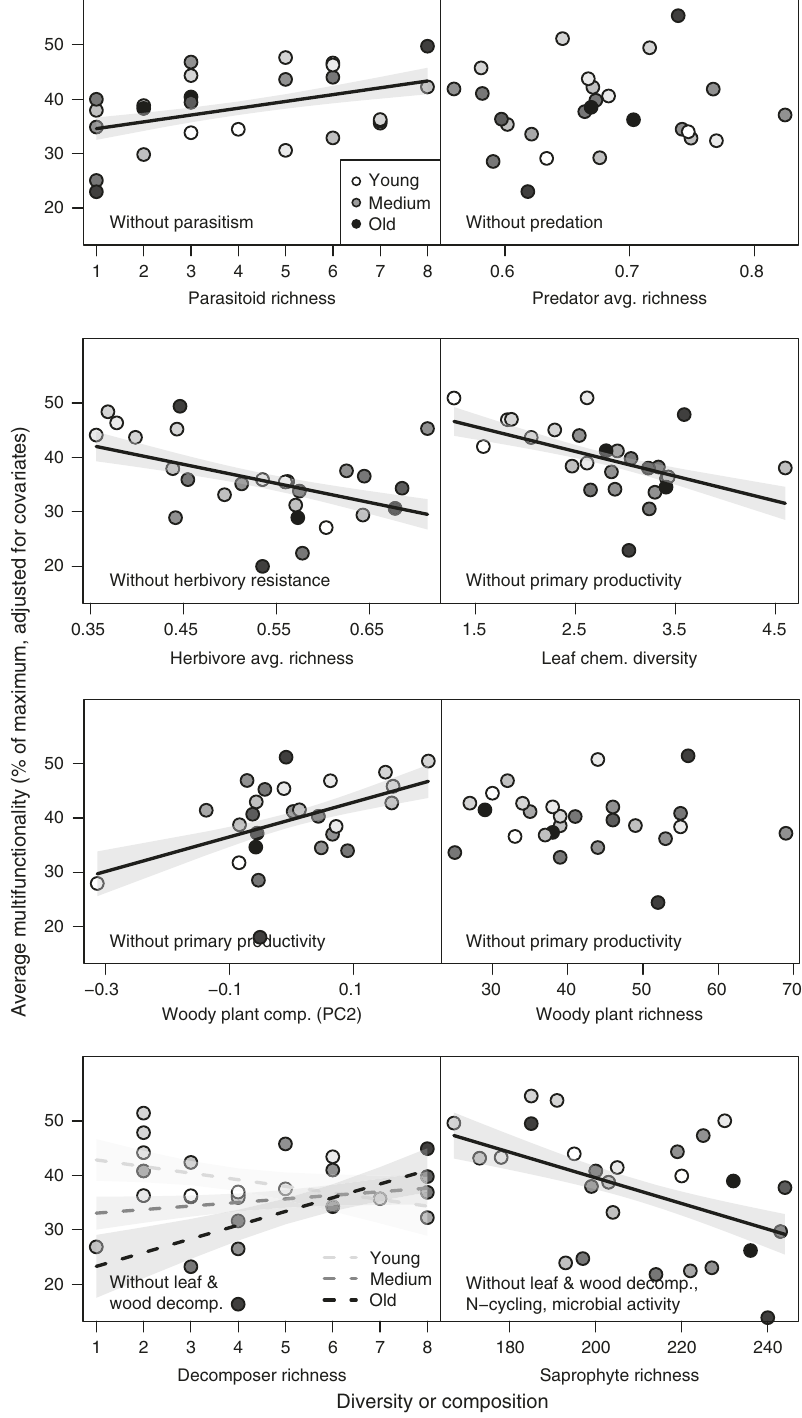
Fig. 3 Biodiversity effects within individual trophic levels on average multifunctionality. Effects of individual models on woody plant diversity and composition, or heterotrophic species richness of individual trophic levels on multifunctionality as the average of fi ve to eight standardized ecosystem functions (excluding functions directly mediated by a given trophic level). Values on the x -axis represent either increasing diversity or differences among study plots in species composition. Note that y -axis values show data adjusted for covariates (see Supplementary Fig. 12 for raw data). Solid regression lines ( ± 1 SE, fi tted across all 26 plots, except for decomposer diversity, where lines are model predictions for young (40 years), medium (70 years), and old (100 years) forest stands) are adjusted for covariates and indicate signi fi cant ( P ≤ 0.05) relationships. Broken lines indicate marginally signi fi cant ( P < 0.07) relationships. The stand age of the study plots is indicated by a continuous gradient from white (youngest plots ~20-year-old) to black (oldest plots > 80-year-old); avg.